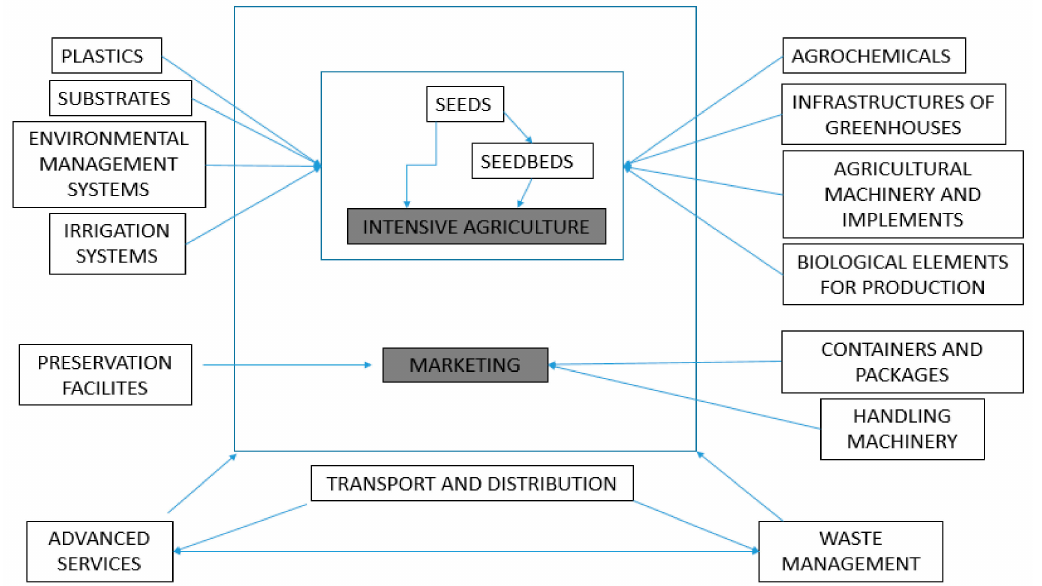
Figure 3. Relationship of auxiliary companies with intensive